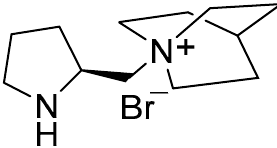
Figure 4. Structure of ( S )-(1-pyrrolidin-2-ylmethyl)quinuclidinium bromide.